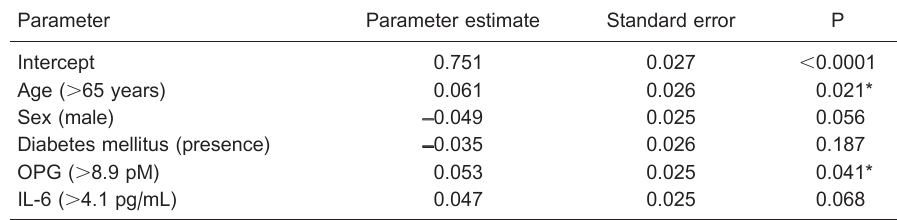
Table 4. Multivariate regression model predicting for intima-media thickness (cm) at time of